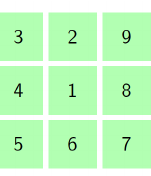
Figure 8. Square tiling in small complex with starting point at the central